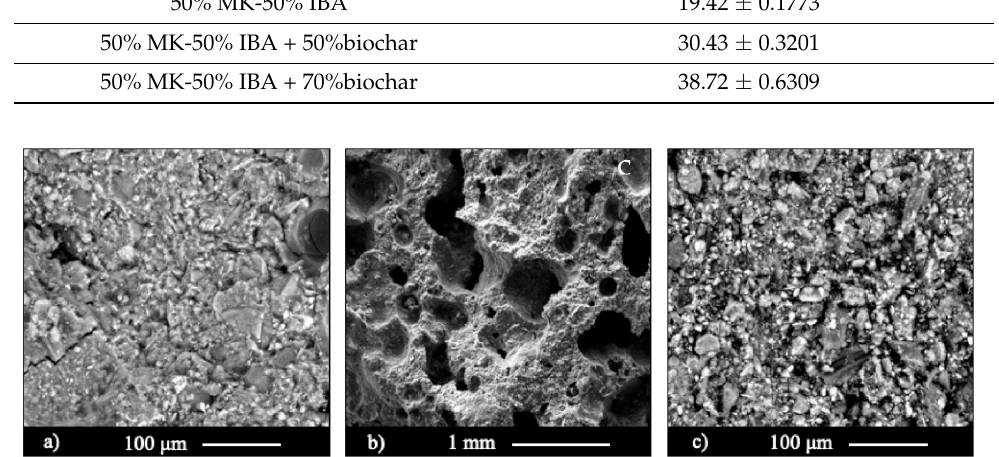
Figure 13. Internal surface of 50% MK-50% IBA ( a ), and ( b ) and 50% MK-50% IBA + 70%Biochar ( c